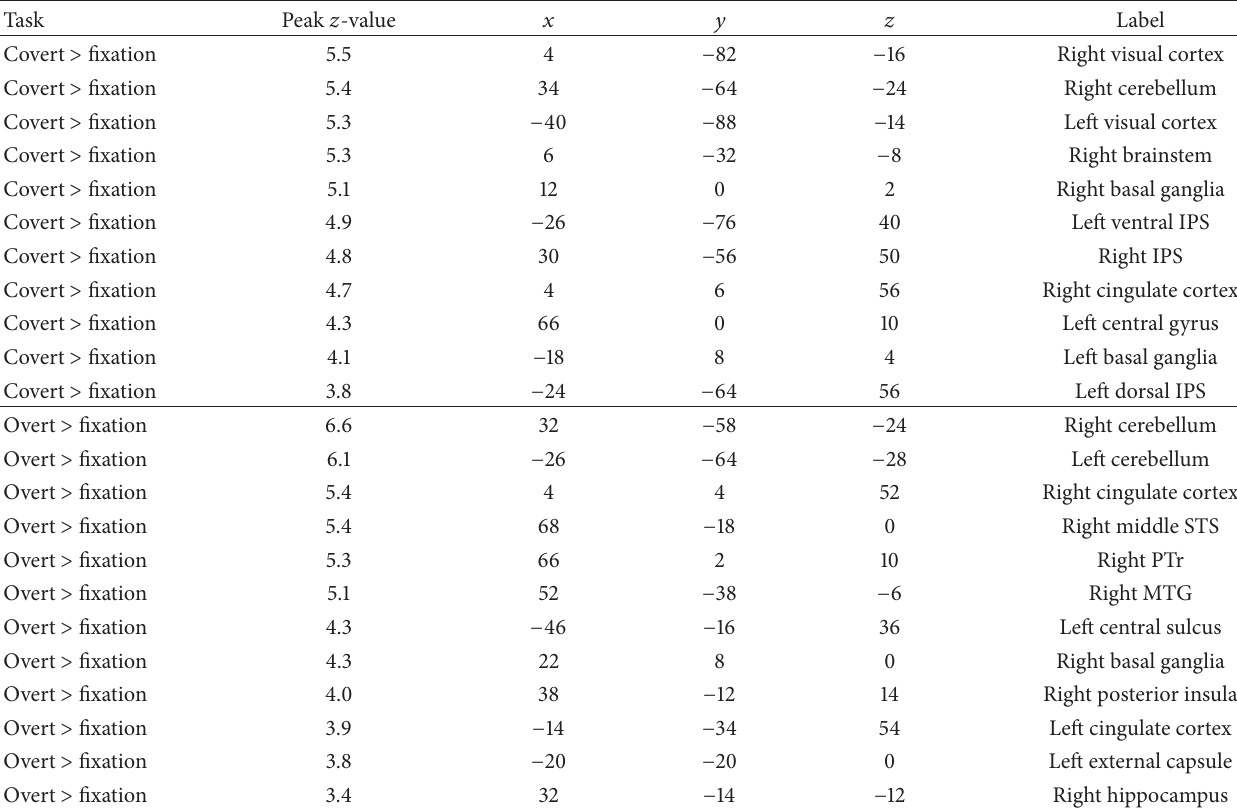
Table 4: MNI coordinates of activity associated with large lesions, for both the covert naming and overt naming contrasts.